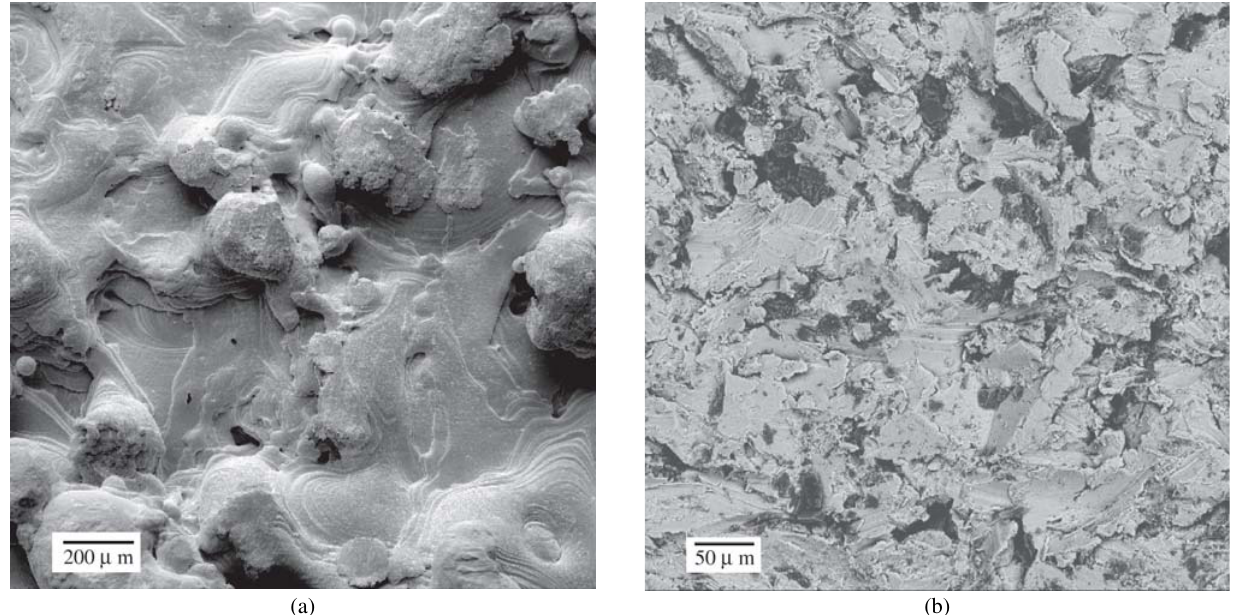
Figure 1. SEM images using different electron detectors: a) topographic image of a titanium orthopedic plate coated with titanium by plasma spray process. SE image; (50 ×); b) residual particles of alumina (darker) on a titanium sheet (brighter) previously submitted to mechanical blasting with alumina. BSE image;